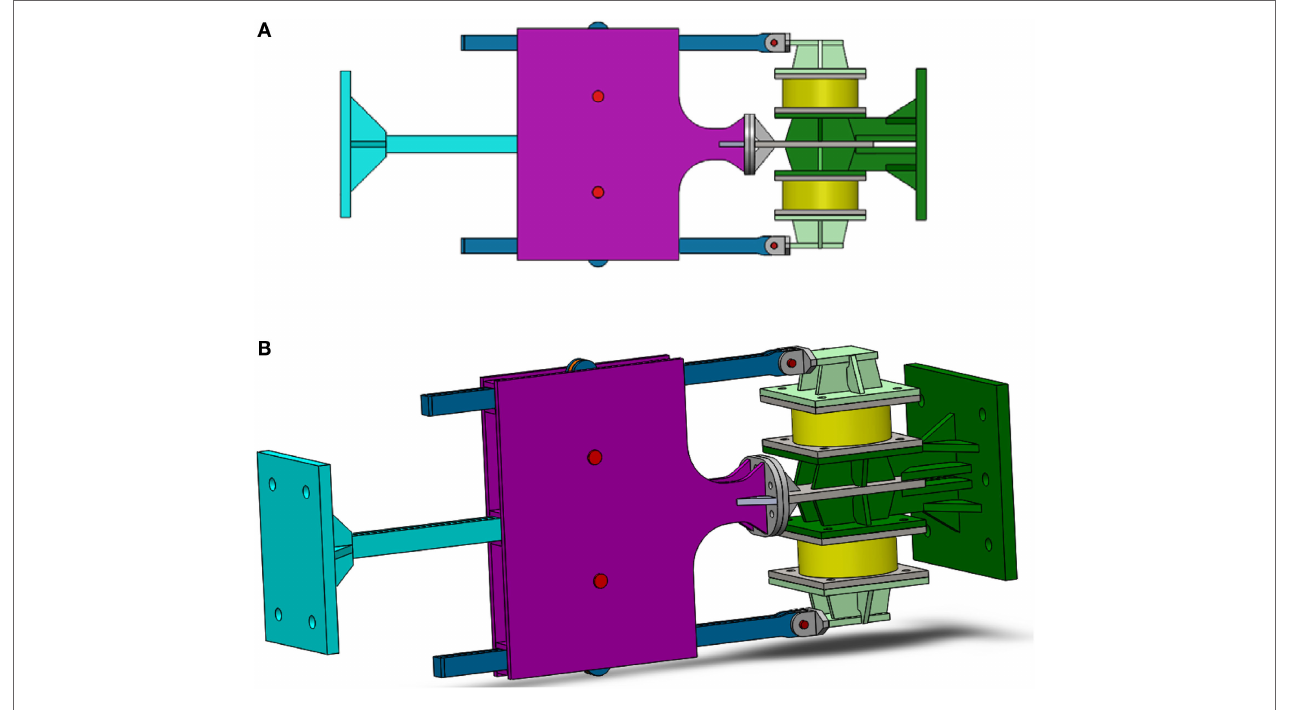
FigUre 1 | solid model of the new damper (a) 2D and (B) 3D .